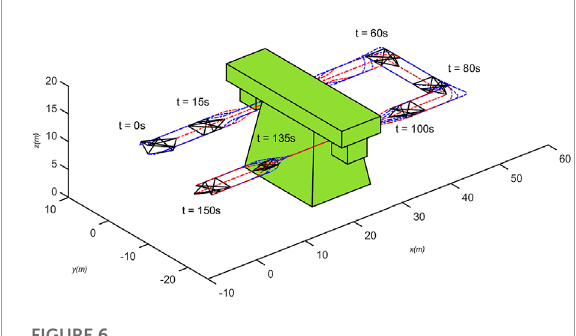
FIGURE 6 Trajectory using control law Eq. 17